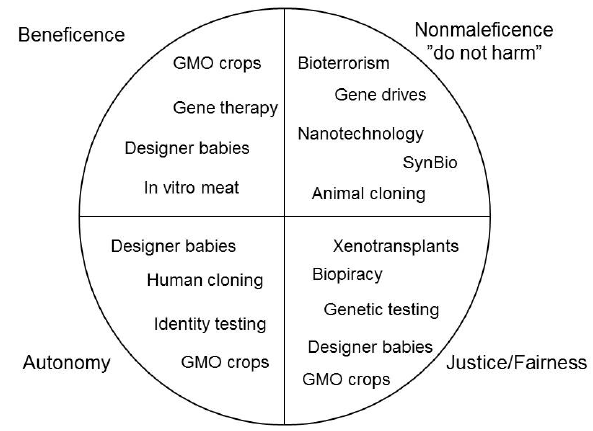
Figure 3: There are four ethical principles that may be used as guide- lines to assess the ethical issues arising from biotechnology. In this figure, emerging biotechnologies were assigned to one of the four principles against which ethical issues have been identified (SynBio stands for Synthetic